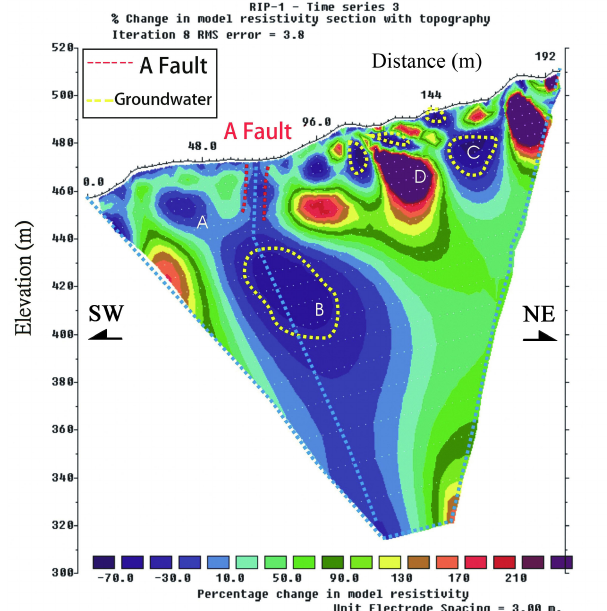
Figure 4. Image profile of RIP-1 (modified from Jeng et al., 2009). The results (percentage change between the first and second mea- surements) reveal that the position of the groundwater body coin- cides with that of the fault zone of the A Fault, indicating that the groundwater flows along the fault zone. It also reveals an increase in groundwater in zones A, B, and C and a decrease in zone D.